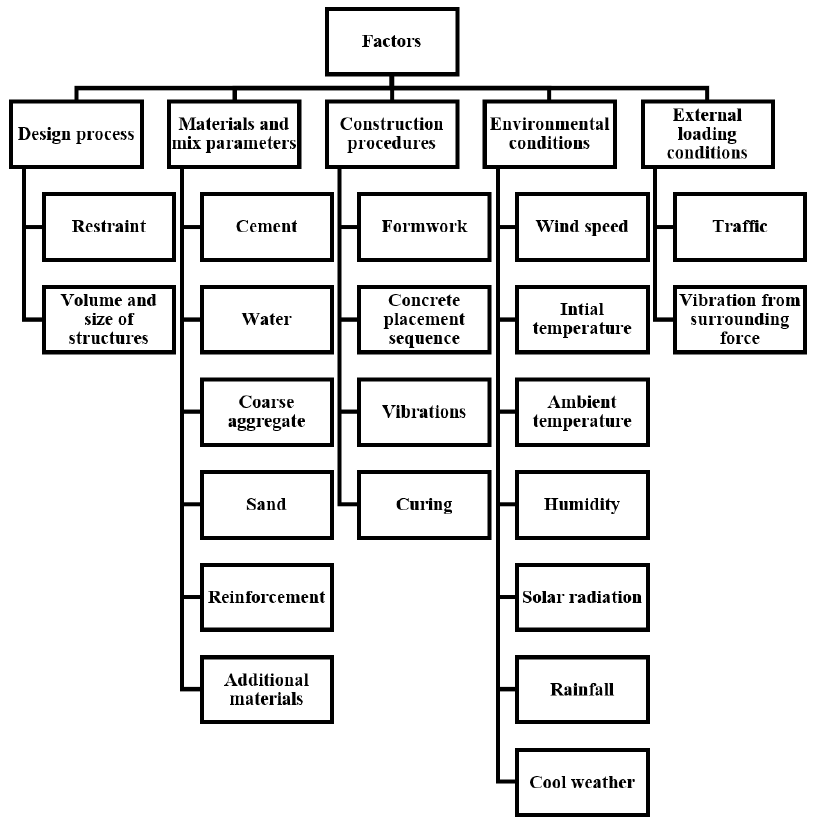
Figure 7. Various factors which influence cracking of hardened concrete.